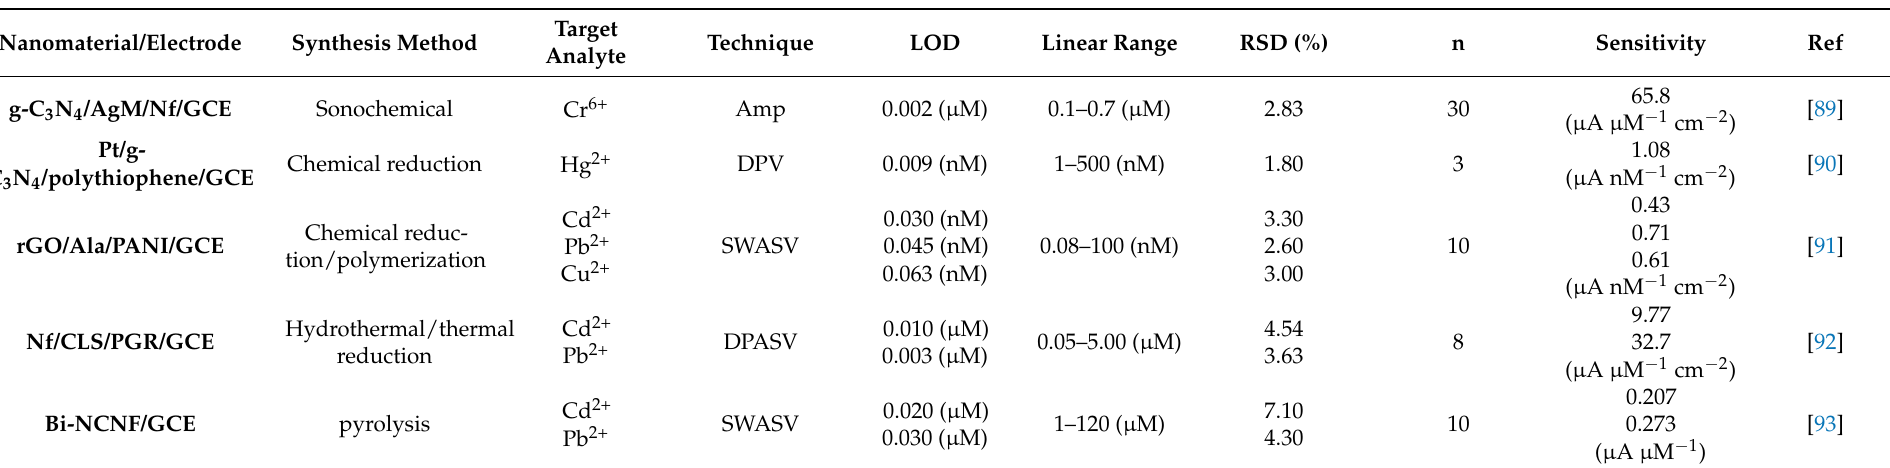
Table 1. Electroanalytical performances of selected carbon nanocomposite-based sensors for trace metal detection in environmental water